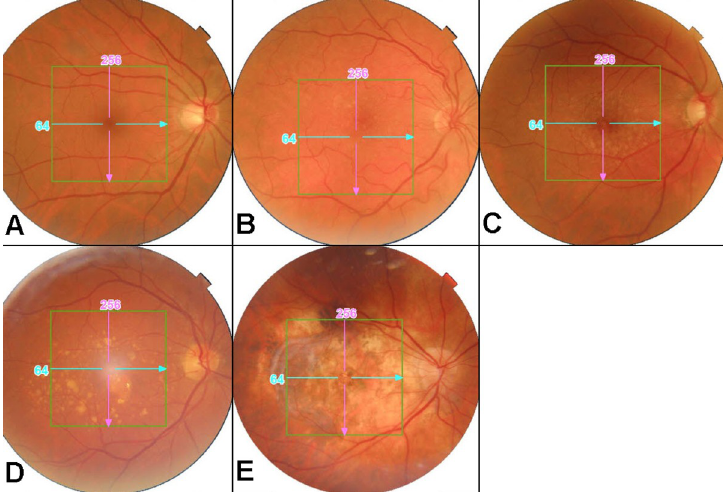
Fig 1. Fundus photo grading. Examples of fundus photos grading: photos graded as score 0 (A), score 1 (B), score 2 (C), score 3 (D) and score 4 (E).